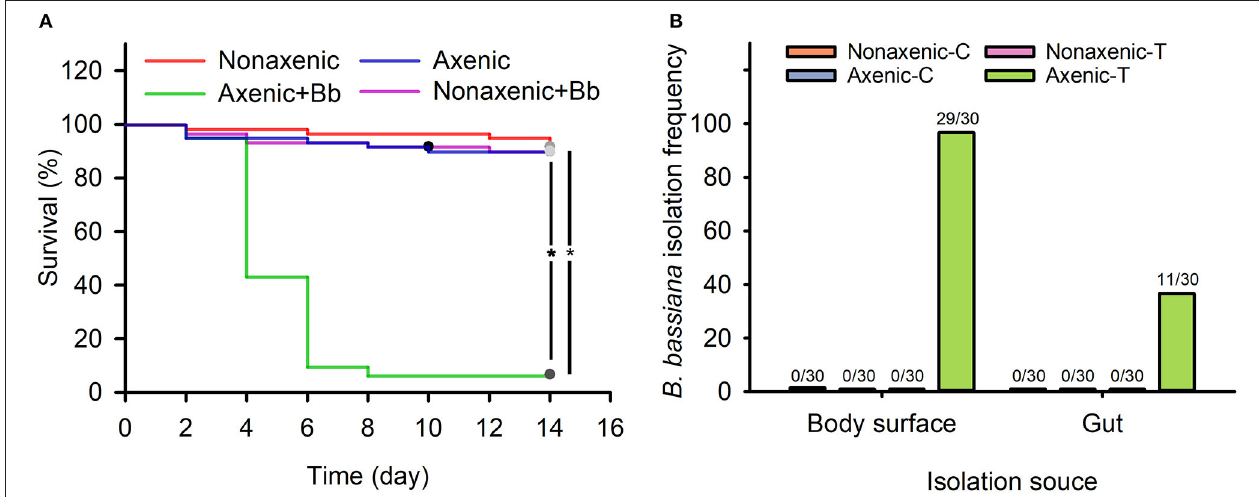
FIGURE 1 | Associated microbiota inhibited B. bassiana infection of D. antiqua larvae and colonization of the fungus on D. antiqua larvae. Survival of axenic and non-axenic D. antiqua larvae treated with B. bassiana BB1101 (A) . The red, blue, green, and pink lines refer to survival of non-axenic larvae without B. bassiana treatment, axenic larvae without B. bassiana treatment, non-axenic larvae treated with B. bassiana , and axenic larvae treated with B. bassiana , respectively. B. bassiana isolation frequency (B) from non-axenic larvae treated with phosphate-buffered saline (PBS) (non-axenic-C), axenic larvae treated with PBS (axenic-C), non-axenic larvae treated with B. bassiana conidial suspension (non-axenic-T), and axenic larvae treated with B. bassiana conidial suspension (axenic-T). Larval survival was estimated with Kaplan–Meier analysis ( n = 30, one representative experiment of three, log-rank test, α = 0.05). Asterisk ( * ) denotes a significant difference between the two connected lines.